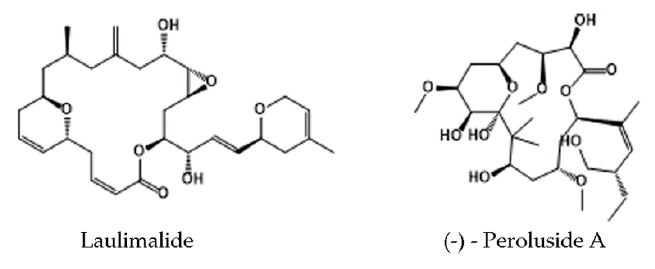
Figure 4. Structure of laulimalide and peloruside A.